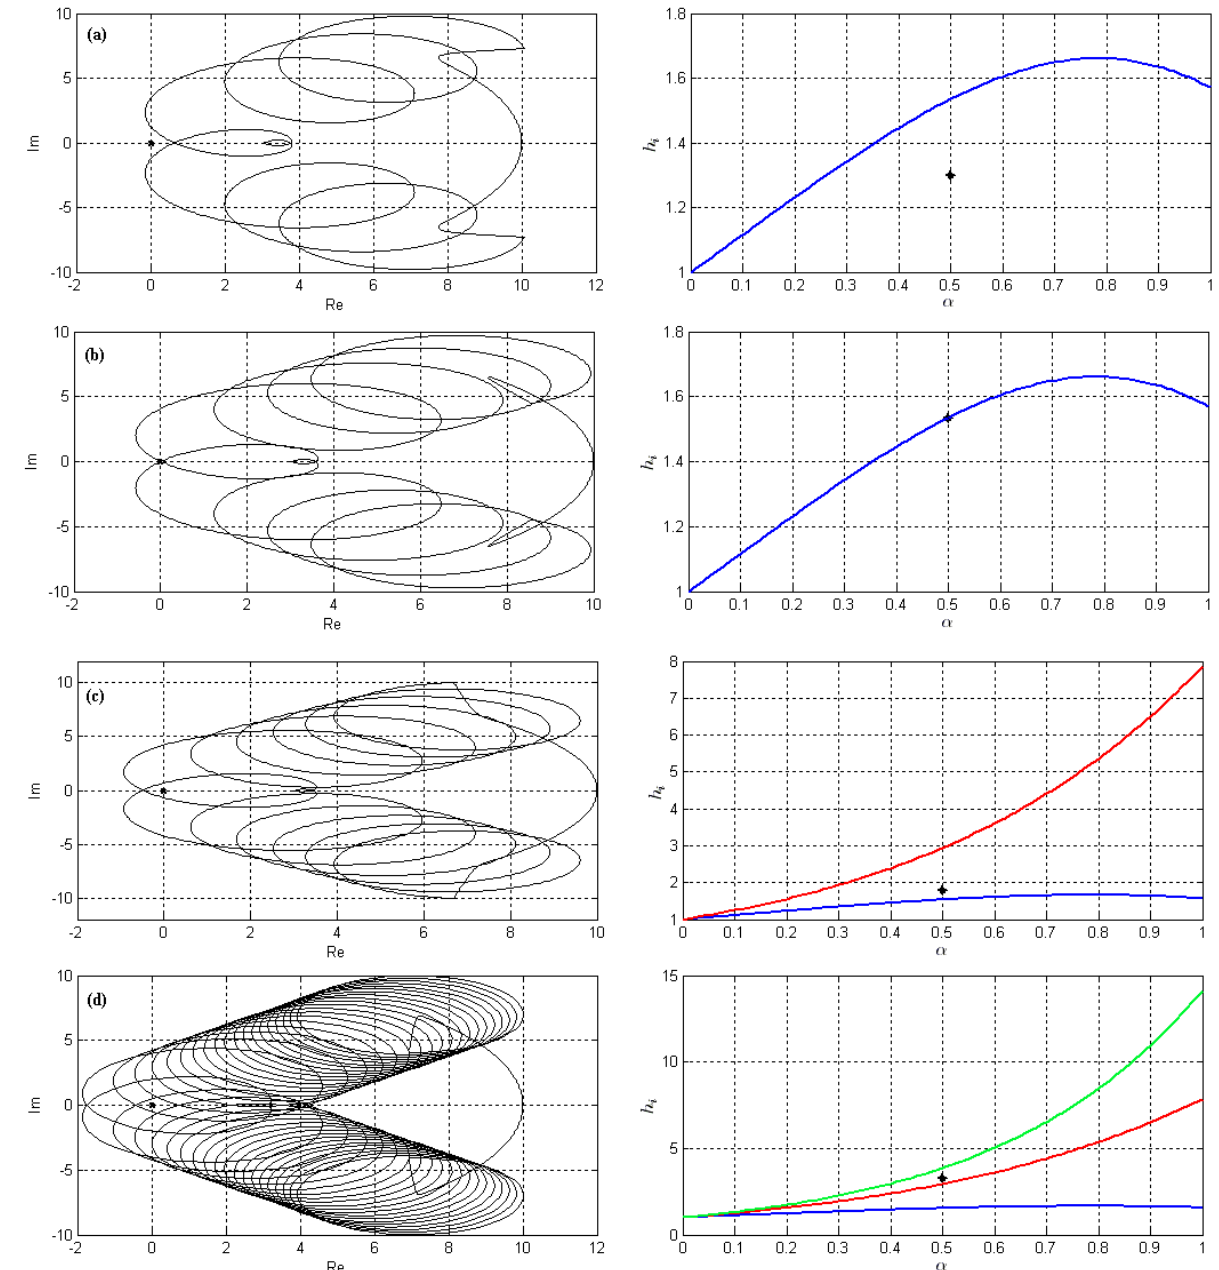
() g s (right figures) where 100 R = for different (the place of these pairs are shown in the left fig-